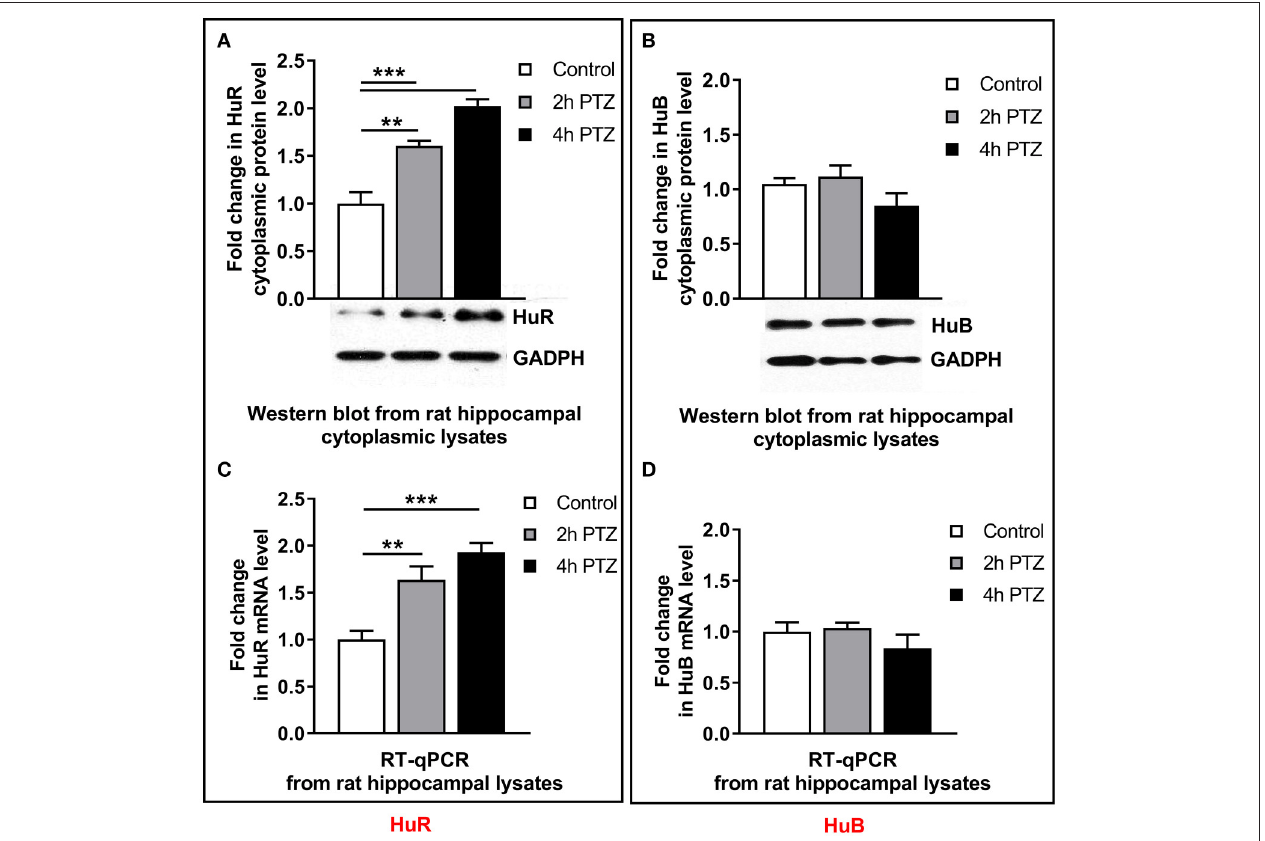
FIGURE 4 | After neuronal activation in the rat hippocampus, the cytoplasmic HuR and HuR mRNA are progressively upregulated, whereas the cytoplasmic HuB and HuB mRNA are stably expressed. We administered 50 mg/kg of PTZ intraperitioneally. Rats were sacrificed at 2 and 4h after the onset of the seizures. For each analysis, equal amounts of the cytoplasmic protein extracts or RNA isolated from the unstimulated (control) and PTZ-treated (2 and 4h after the onset of seizures) rat hippocampi were used and analyzed by Western blotting or qRT-PCR, respectively. (A) HuR accumulates progressively in the hippocampal cell cytoplasm after PTZ-evoked neuronal activation. GAPDH was used as a loading control. Representative cropped Western blots are shown. Graph data is presented as fold change in the protein expression. One-way ANOVA was followed by Tukey’s multiple comparisons test. Values are mean ± SEM (** p < 0.01; *** p < 0.001; n = 5). (B) HuB is stably expressed in the hippocampal cell cytoplasm after PTZ-evoked neuronal activation. GAPDH was used as a loading control. Representative cropped Western blots are shown. Graph data is presented as fold change in the protein expression. Kruskal–Wallis test was followed by Dunn’s multiple comparisons test. Values are mean ± SEM ( n = 5). (C) HuR mRNA accumulates progressively after PTZ-evoked neuronal activation in the rat hippocampus. HuR mRNA expression was normalized against 18S rRNA expression. Data are presented as fold change in mRNA expression. One-way ANOVA was followed by Tukey’s multiple comparisons test. Values are mean ± SEM (* p < 0.05; ** p < 0.01; *** p < 0.001; n = 5). (D) HuB mRNA is stably expressed after PTZ-evoked neuronal activation in the rat hippocampus. HuB mRNA expression was normalized against 18S rRNA expression. Data are presented as fold change in mRNA expression. Kruskal–Wallis test